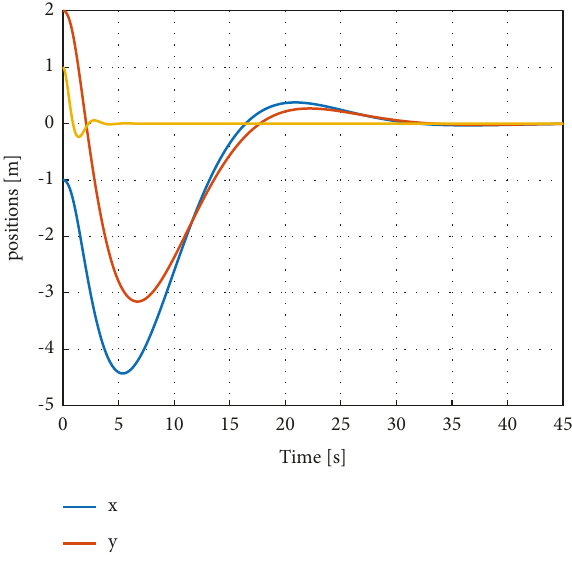
Figure 10: Positions x , y , and z with an additional proportional controller gain k system states to